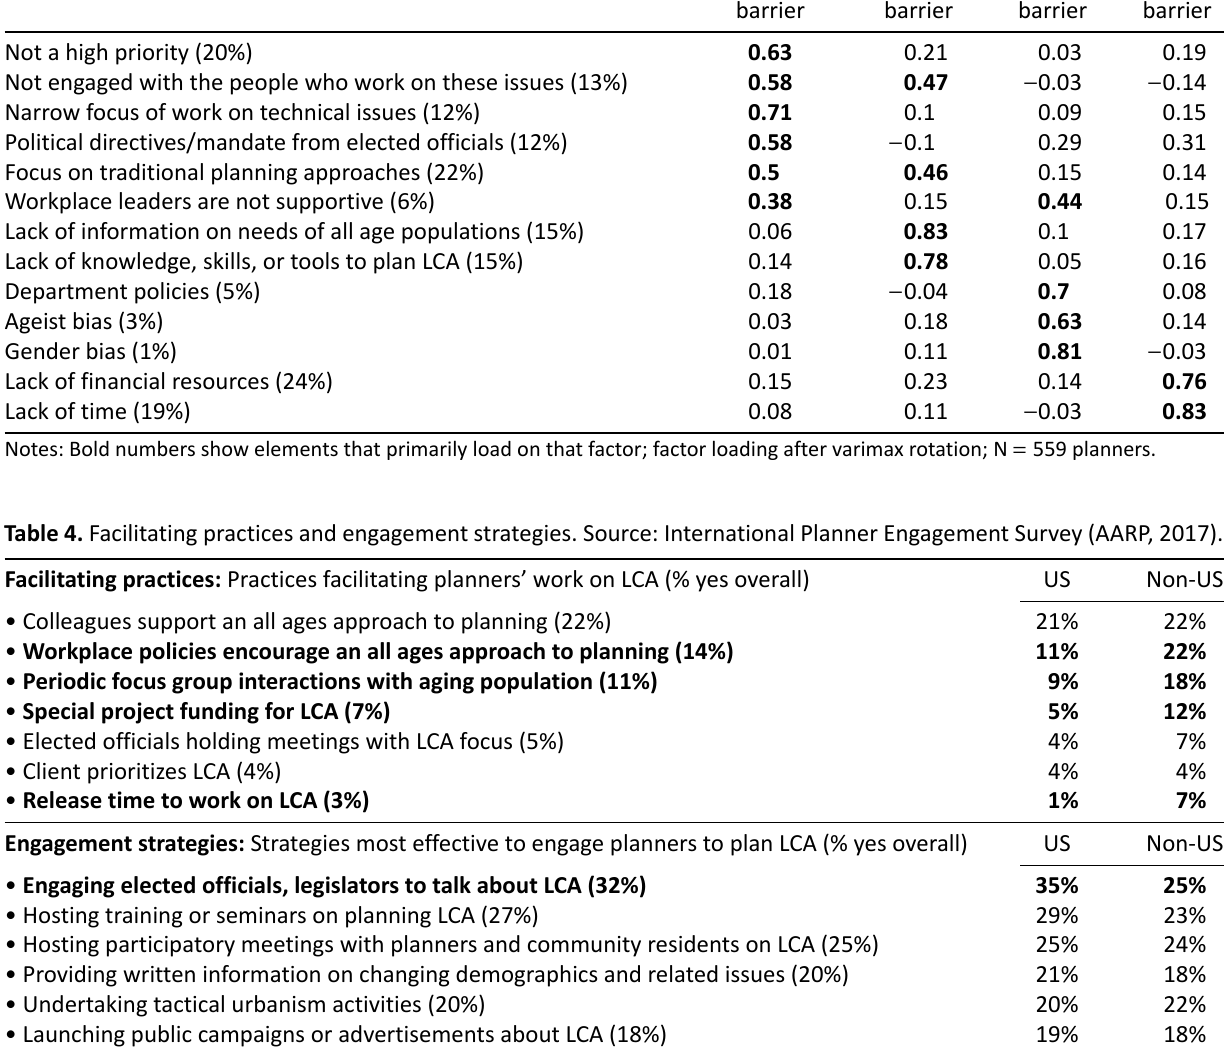
Table 3. Factor analysis of LCA barriers. Source: International Planner Engagement Survey (AARP, 2017). Barriers: catalysts/motivators for planners to participate in planning LCA? (% yes overall)